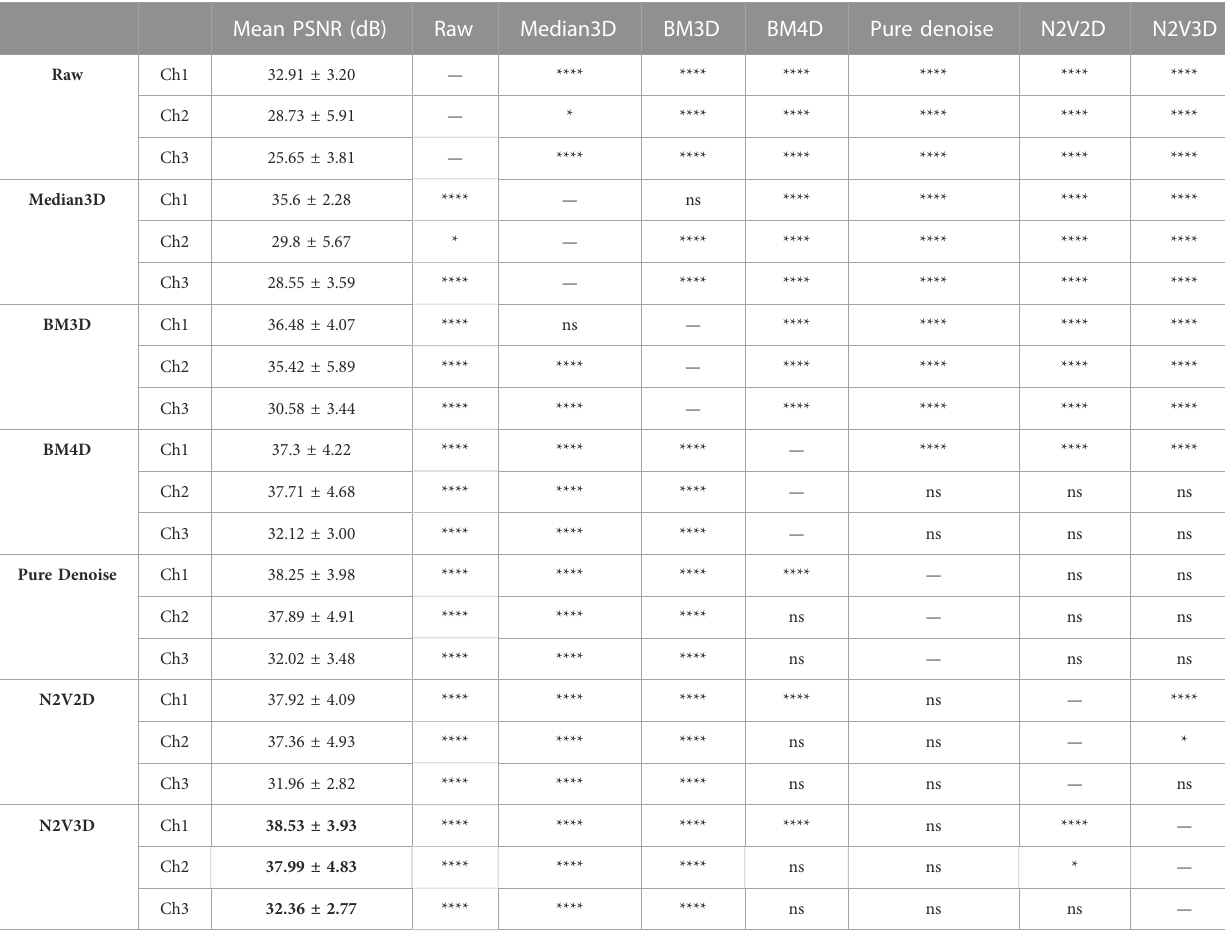
TABLE2Imagedenoisingperformanceonvalidationdataset(n=1,125slices)measuredwithmeanPSNRandexpressedindB,highestvaluesarehighlightedwith a bold font. The multiple comparisons were performed with Dunn ’ s